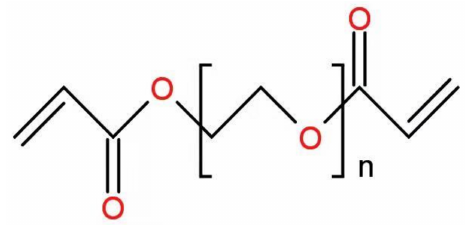
Figure 2. Chemical formula of PEGDA.